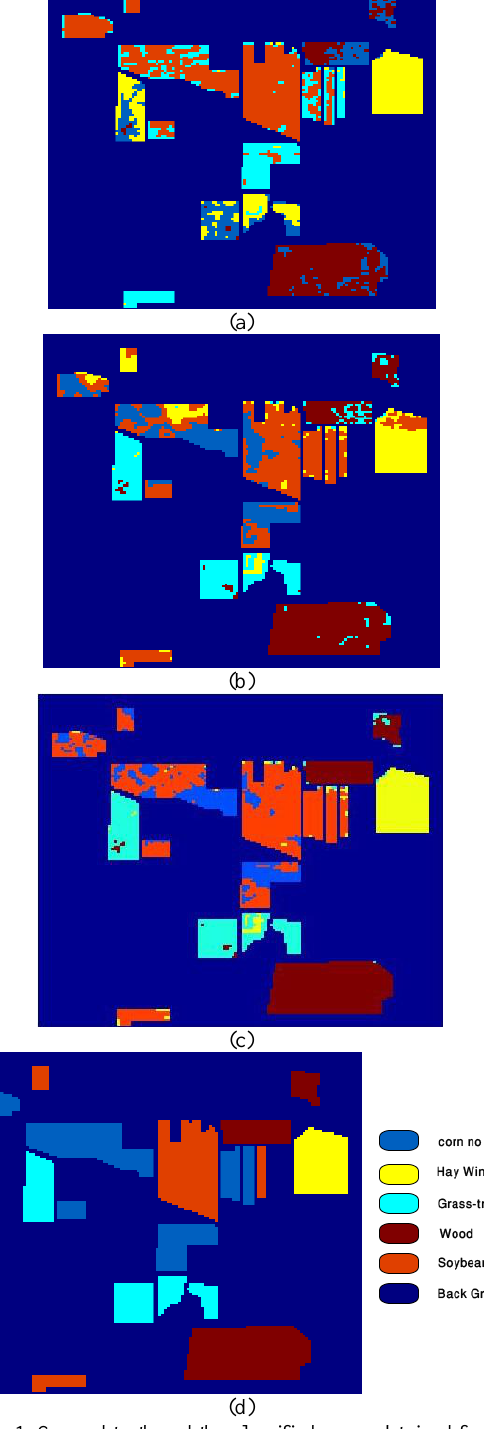
Fig 1. Ground truth and the classified maps obtained from different algorithms. (a) FCM, (b),K-Means,(c) MMC,(d)Ground